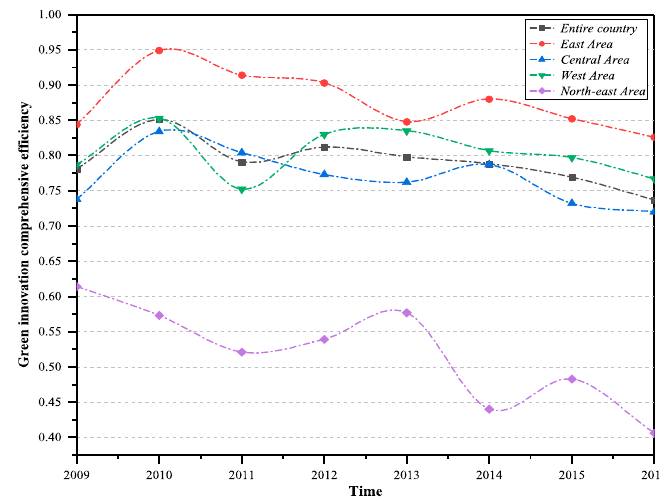
Figure 4. Green technology innovation achievements in transformation efficiency of the country and the four major regions (2009 – 2016).